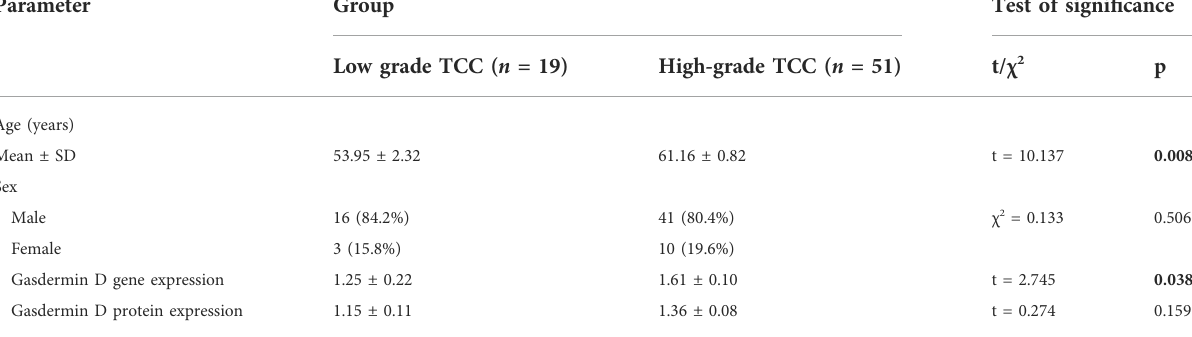
TABLE 5 Patients ’ characteristics, gasdermin D gene and protein expression in tissue samples in cases with low- and high-grade transitional cell carcinoma: Parameter